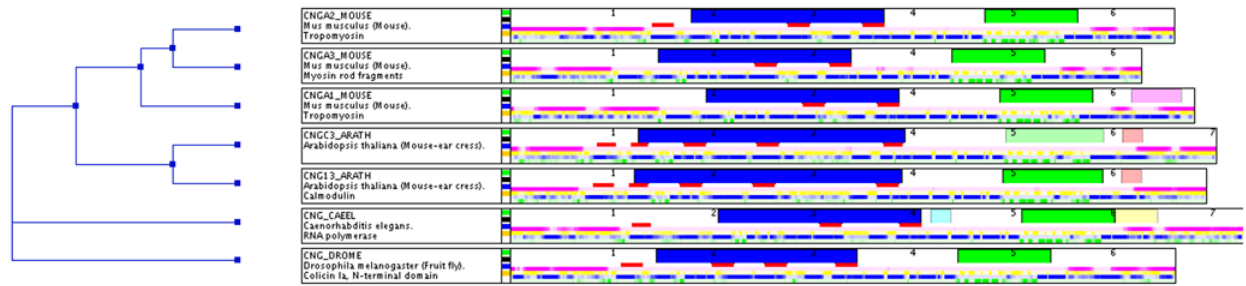
Figure 1. A ProteinArchitect result that illustrates several features (described in the text).